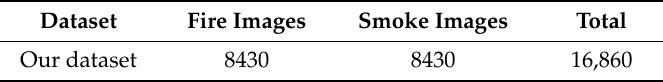
Table 1. Distribution of images in the dataset.